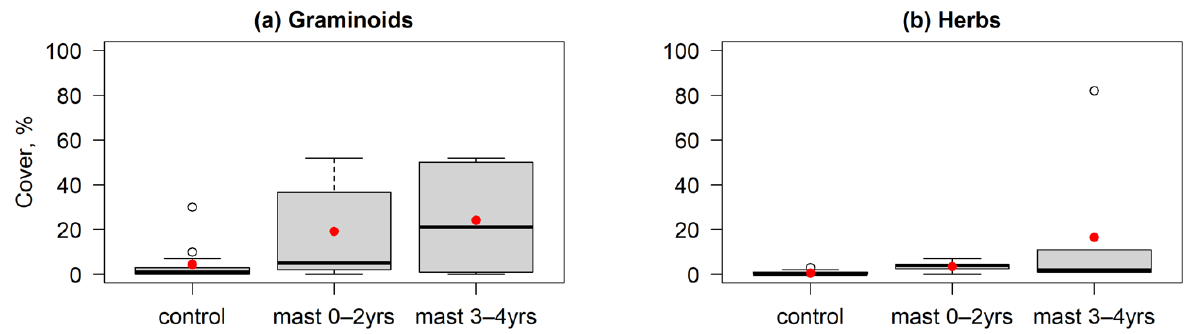
Figure 8. Cover abundance of exotic species: ( a ) graminoids; and ( b ) herbs for 0–2 years post mastication, 3–4 years post mastication and control.